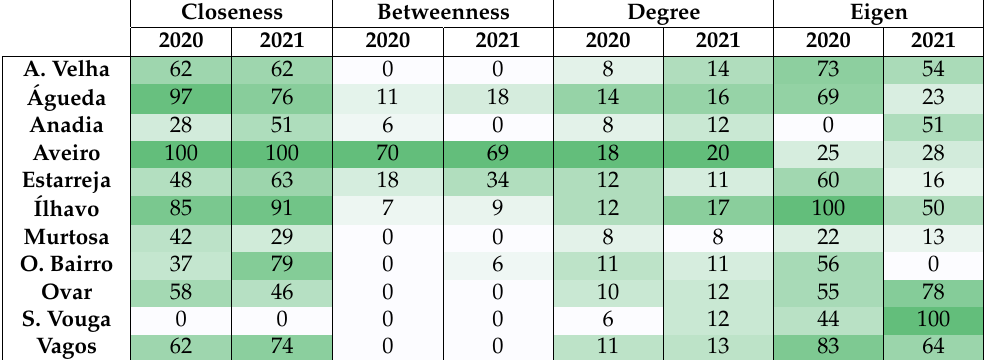
Table 3. Centrality Measures of the digraph related to the municipality data in 2020 and